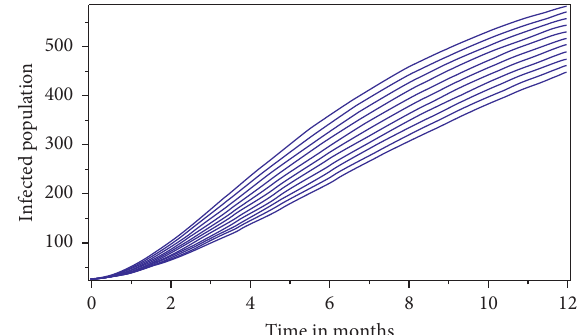
Figure 7: Approximate solution of infectious cows for ϕ � 1.